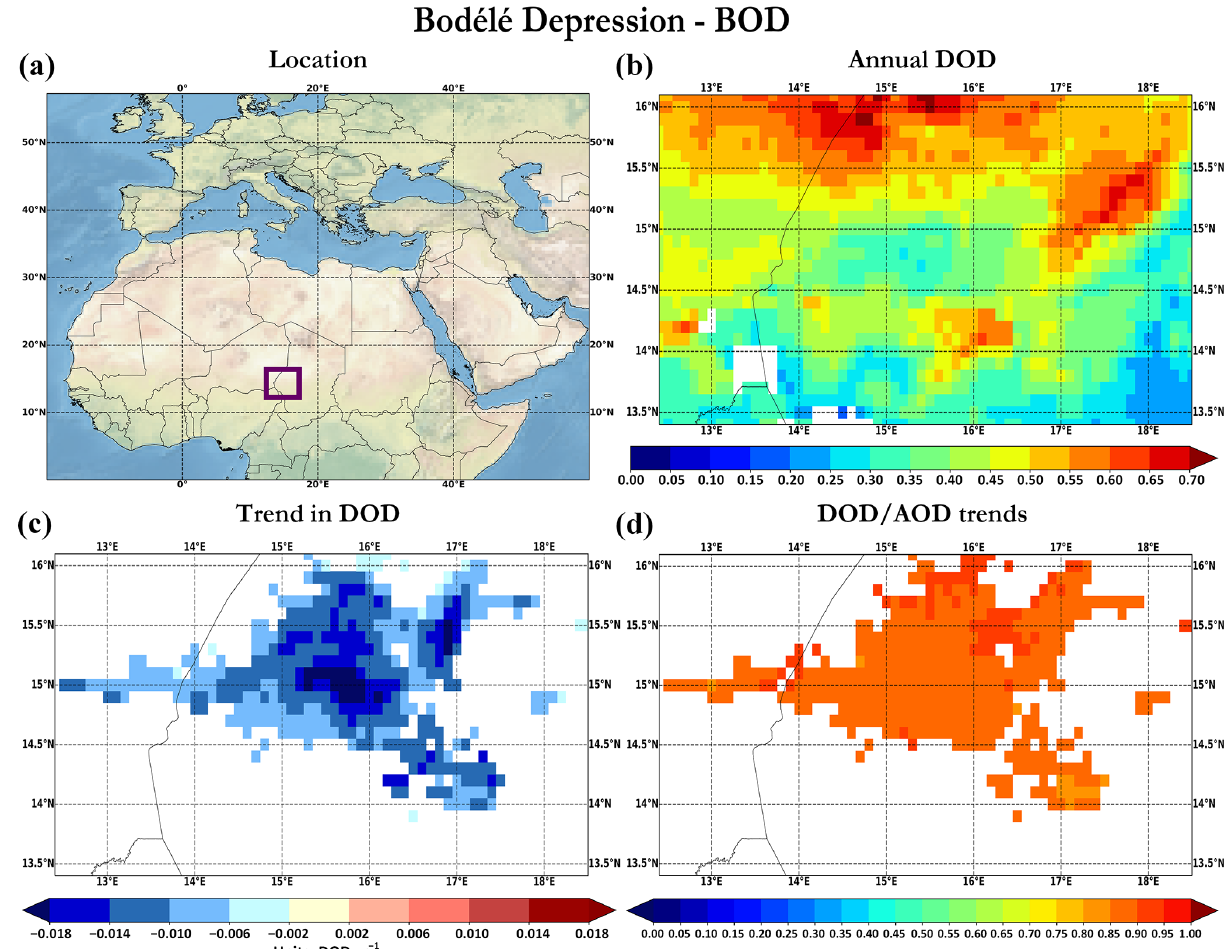
Figure 13. Same as Fig. 10, but for the Bodélé